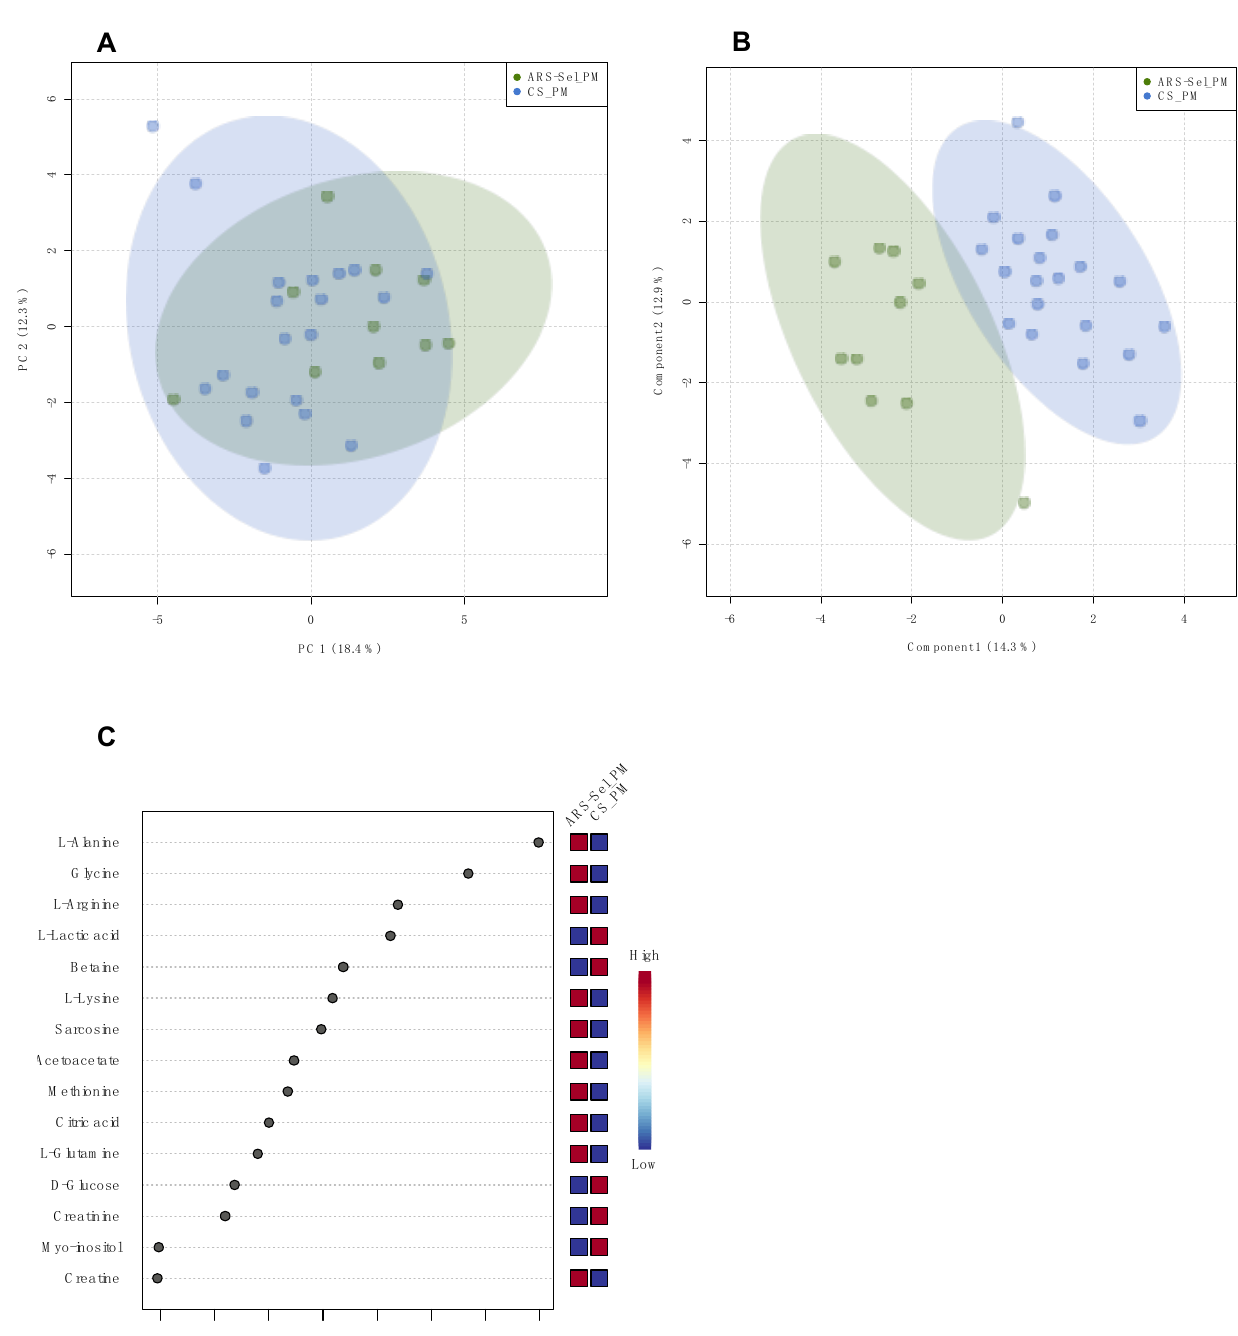
Figure 2. Multivariate analysis of groups ARS- Sel _PM and CS_PM in plasma: ( A ) PCA scores plot; ( B ) PLS scores plot, model validated (NC = 2; R 2 = 0.826; Q 2 = 0.543; 1000 permutations: p = 0.025); ( C ) VIP of the PLS scores plot model.